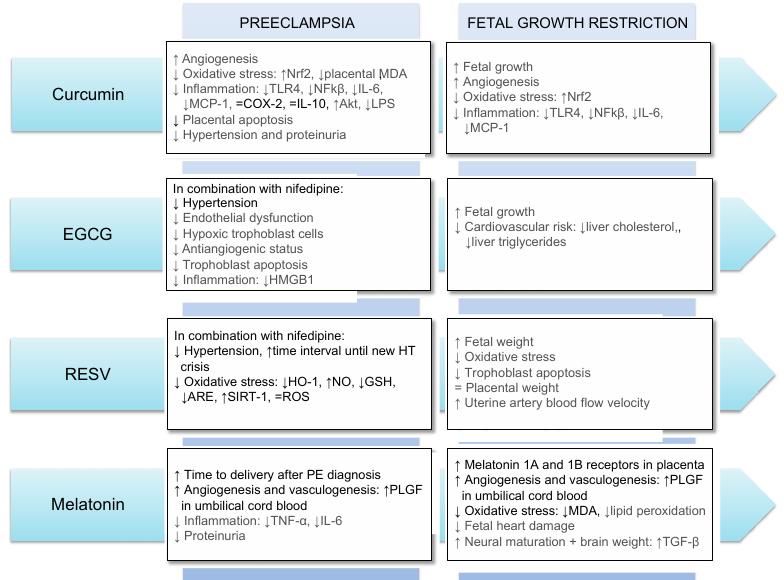
Figure 2. Main effects of the use of curcumin, EGCG, resveratrol and melatonin in preeclampsia and fetal growth restriction. Results in gray and black refer to those obtained in animal models and human, respectively. Abbreviations: Akt: Protein kinase B; ARE: antioxidant response element; COX-2: Cyclooxygenase-2; GSH: glutathione; HMGB1: high-mobility group box 1; HO-1: heme ox- ygenase-1; HT: hypertension; IL-6: interleukin-6; IL-10: interleukin-10; LPS: lipopolysaccharides; MCP-1: monocyte chemoattractant protein-1; MDA: malondialdehyde; NFk β : nuclear factor κ B; NO: nitric oxide; Nrf2: NFE2-related factor-2; RESV: resveratrol; ROS: reactive oxygen species; SIRT- 1: sirtuin-1; TGF- β : transforming growth factor-beta; TLR4: Toll Like Receptor 4; TNF- α : tumor ne- crosis factor-alpha; PLGF: placental growth factor; ↓ : decrease; ↑ : increase; =: no difference.